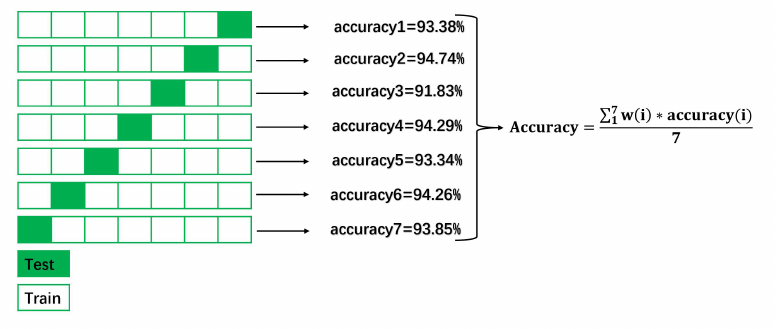
Figure 5. The 7-fold cross-validation flow chart of Sleep-EDF database 4 classification.